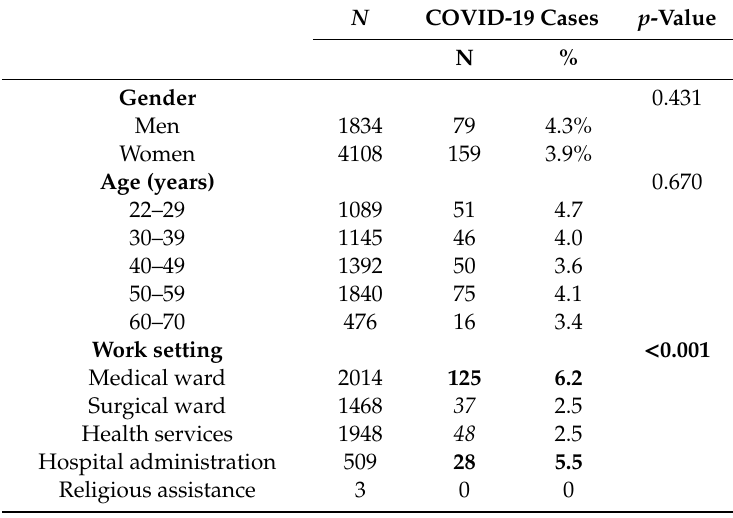
Table 3. COVID-19 cases in 5942 workers of Verona University Hospital, as a function of main demographic and occupational